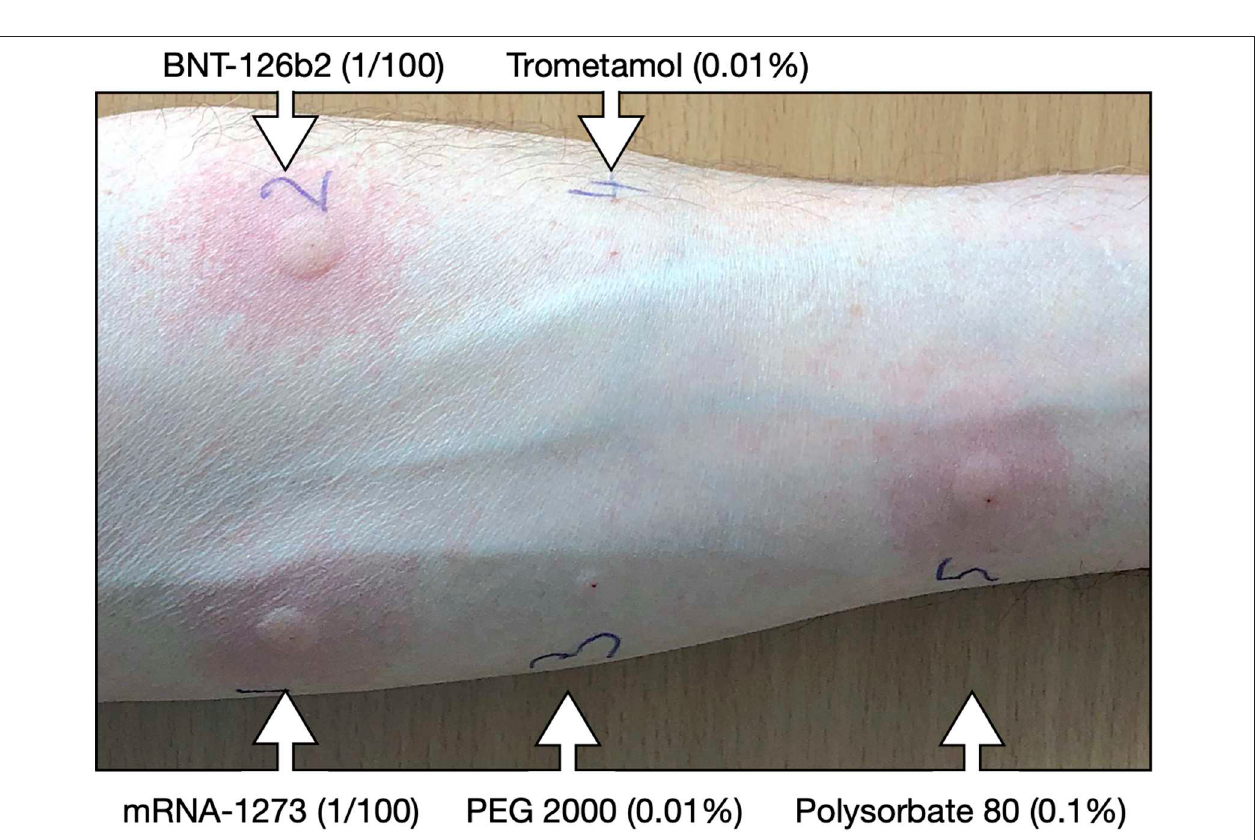
kept as close as possible to 4 weeks (mean 41 days, SD ± 14.95 days). Thus, in the majority of the cases, skin testing (if negative) and vaccination were set up the same day. Notably, over 95% (55/58) of individuals with negative skin tests (SPT and IDR) tolerated a two-step rechallenge protocol ( Figure 2 ).